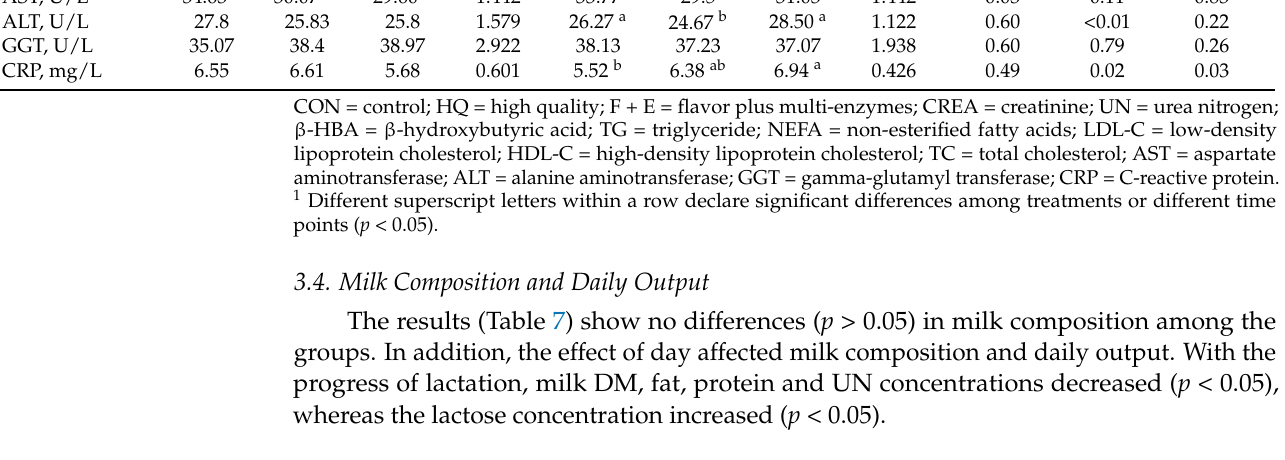
Table 7. Milk composition and daily output of lactating